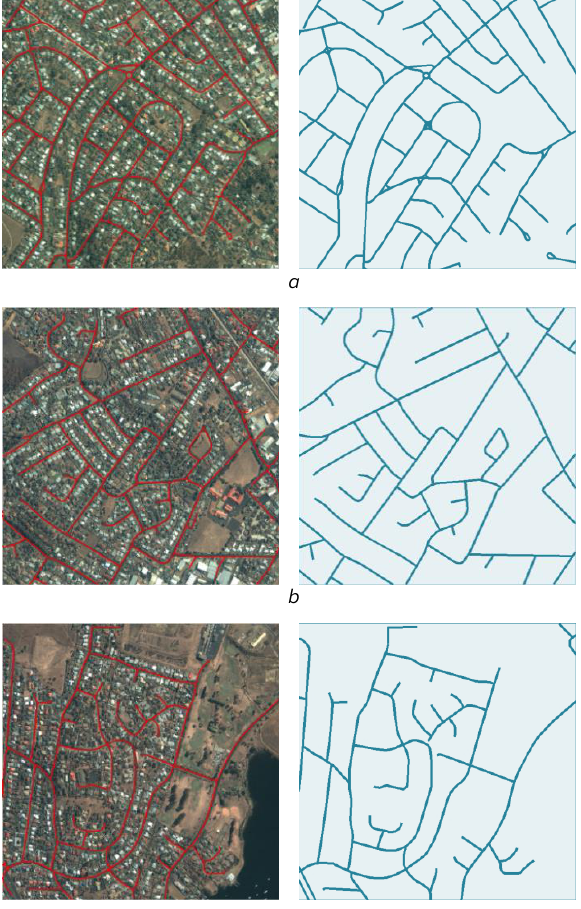
c Figure 4. Second dataset. Road extraction results are depicted in left column and right column images illustrate the ground truth.